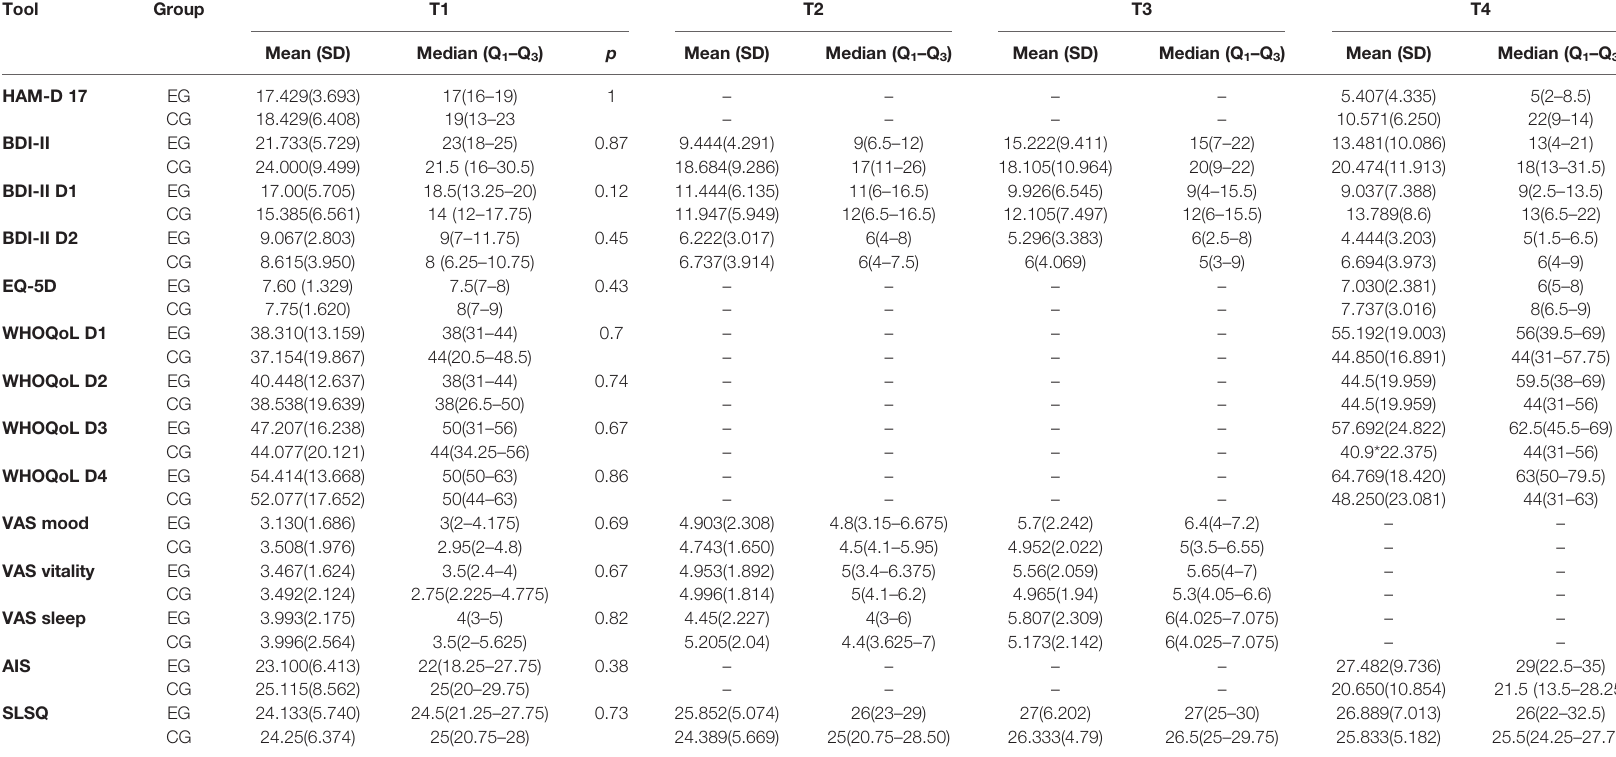
TABLE 3 | Obtained results T1, T2, T3, and T4.